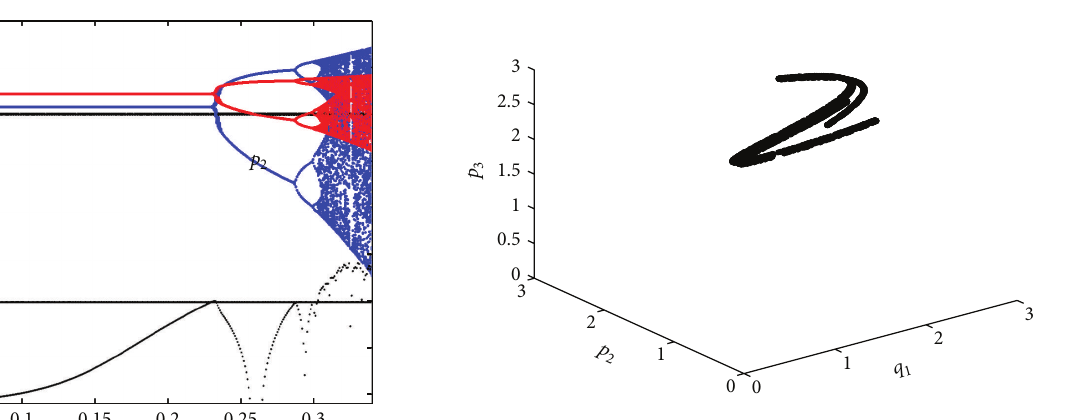
Figure 5: Strange attractors for 𝛼 = 1.35 , 𝛽 = 0.3 , and 𝛾 = 0.35 .